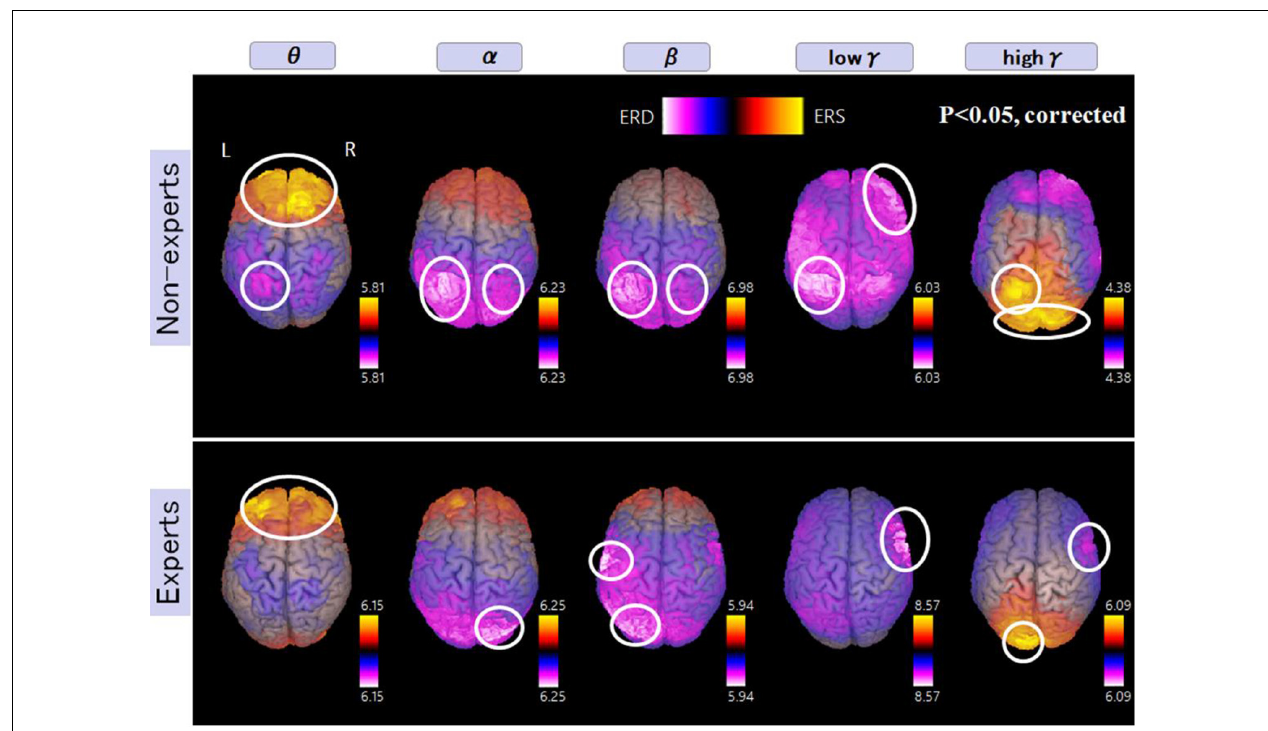
FIGURE 6 | A group average of the spatial distribution of oscillatory changes for the second experiment (mental multiplication during calculation task). The time window is between − 1,500 and 1,500 ms. The frequency interval (all frequency bands) ranges from 4 Hz to 100 Hz. Magenta color shows ERD and orange color shows ERS. The circled areas indicate statistically-significant oscillatory changes. The significant differences observed ( p < 0.05, corrected) in some brain areas are surrounded by a white